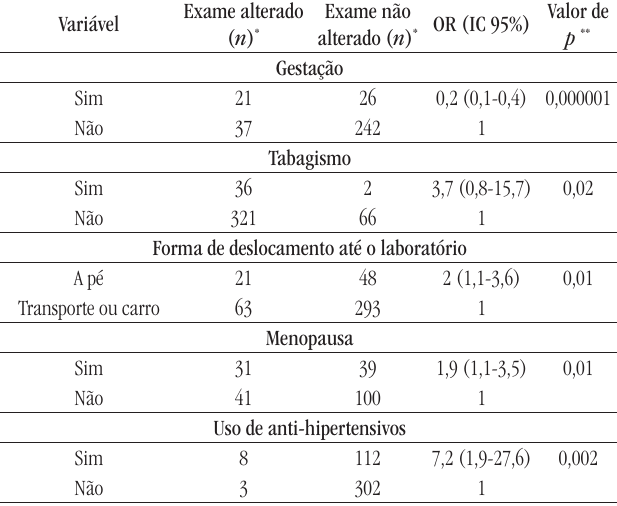
LACEM: Laboratório Central; OR: odds ratio ; * o n pode variar entre as categorias devido a perdas amostrais; ** significância estatística – p < 0,05 em teste